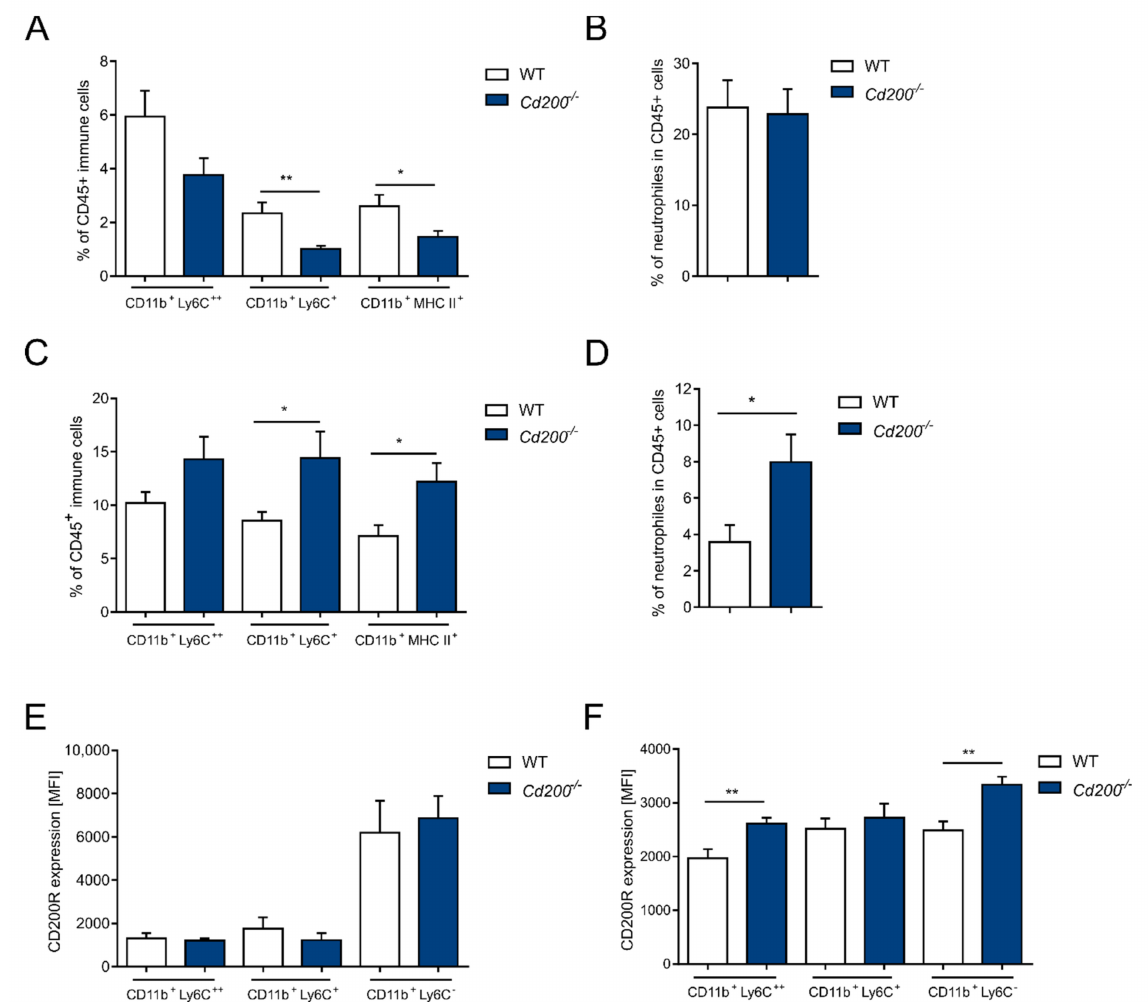
Figure 3. Characterization of myeloid populations in blood and colons of WT and Cd200 − / − mice during DSS-mediated intestinal inflammation. ( A ) Frequency of monocytes (CD11b + Ly6C ++ , CD11b + Ly6C + ), macrophages (CD11b + CD11c − MHC II), and neutrophils (CD11b + Ly6G + ) ( B ) amongst live CD45 + cells in blood from DSS-treated WT and Cd200 − / − mice. A. n = 19, B. n = 13–14; ( C ) Percentage of monocytes (CD11b + Ly6C ++ and CD11b + Ly6C + ), macrophages (CD11b + CD11c − MHC- II + ) and neutrophils (CD11b + Ly6G + ) ( D ) within the live CD45 + cells in colons from DSS-treated WT and Cd200 − / − mice; C. n = 7–10, D. n = 12–15; Expression of CD200R in the particular immune cell populations in the blood ( E ) and colons ( F ) of DSS-treated and Cd200 − / − WT mice. E. n = 6–7, F. n = 6. Results are expressed as mean ± SEM. Significant differences were calculated using Student’s t -test * p < 0.05. ** p < 0.01. compared with WT. MFI: mean fluorescence